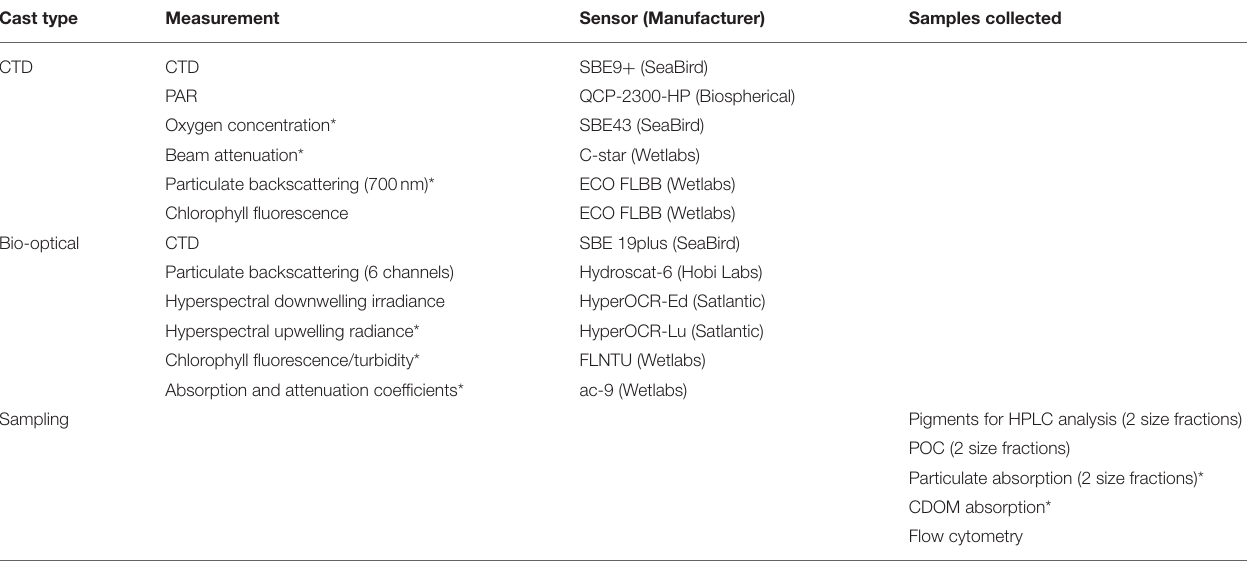
TABLE 1 | Cast types with list of sensors used and sample types collected.